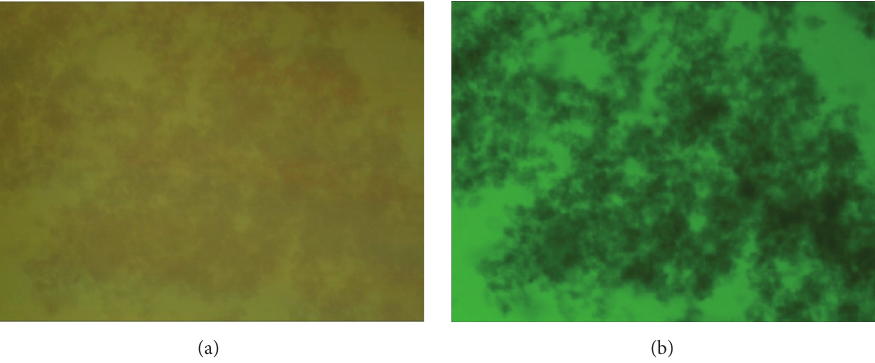
Figure 5: Photos of ferrographic record for sample B: (a) bottom light, (b) upper light.